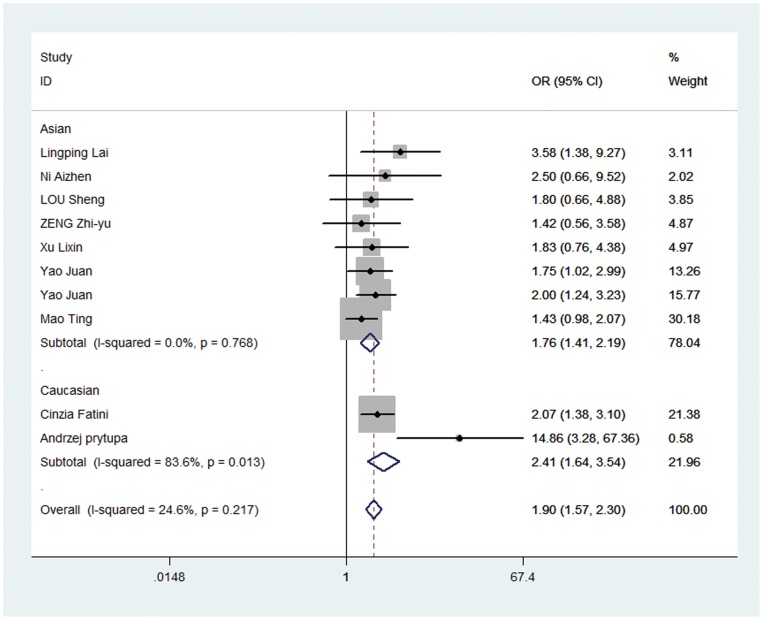
Forest plot of homozygous comparison (GG vs. AA) for overall comparison in fixed-effects model.(OR = 1.899, 95%CI: 1.568, 2.300; Pheterogeneity = 0.217).